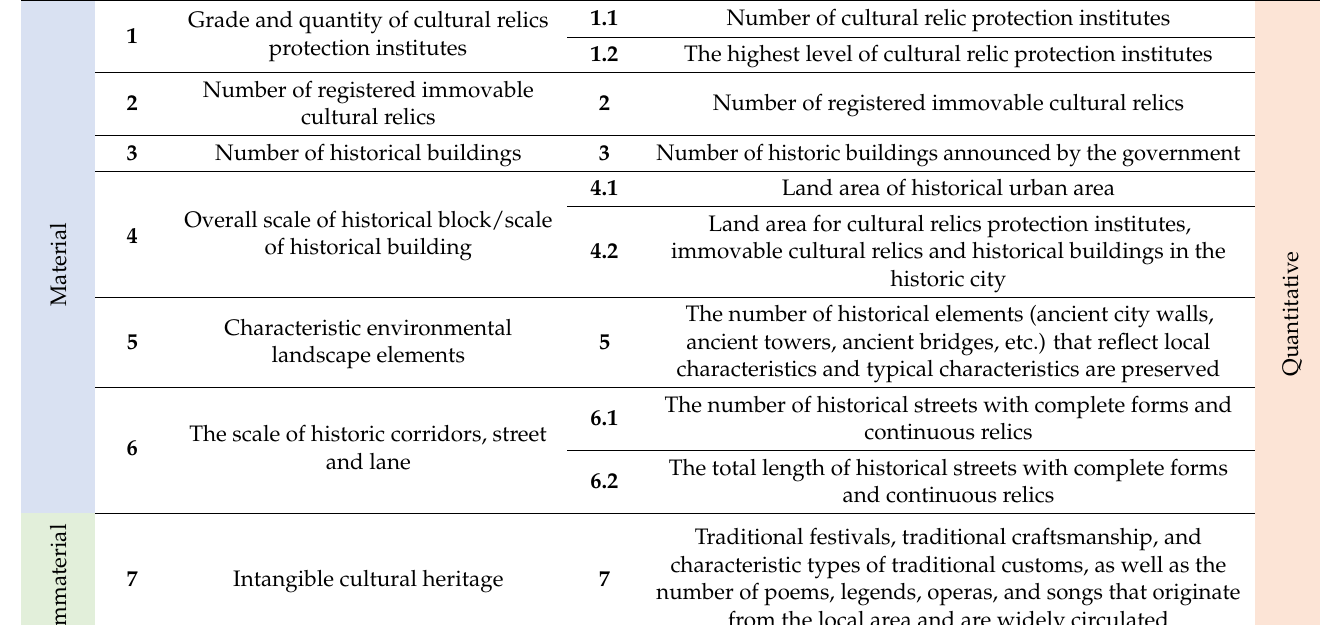
Table 1. The value evaluation framework for historic cities in China (Shenzhen revised version in